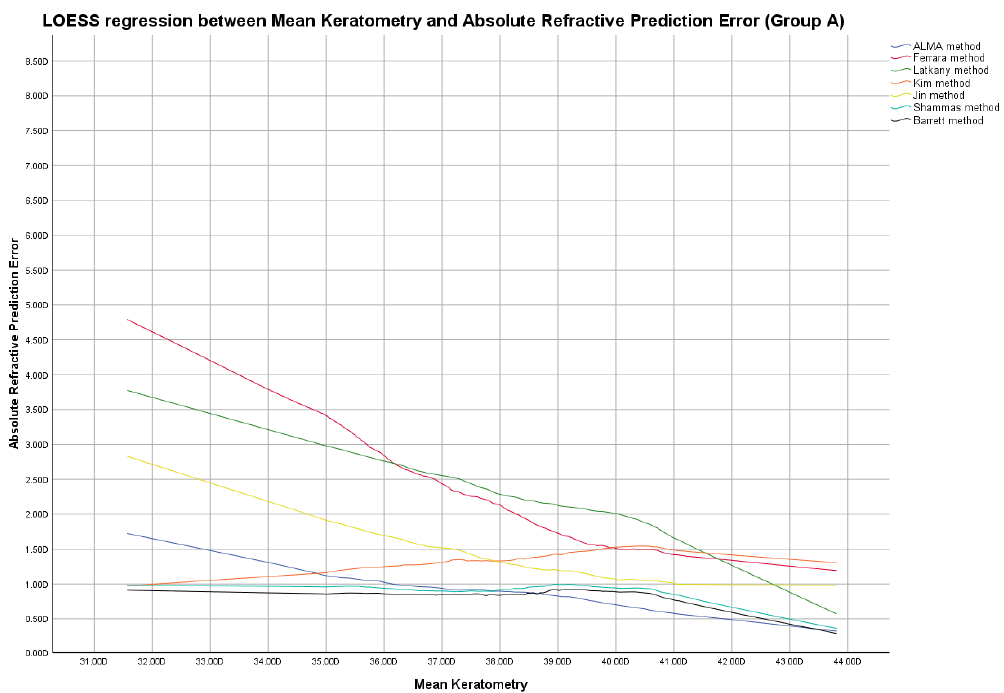
Figure 1. Locally estimated scatterplot smoothing (LOESS) curve between refractive prediction errors generated for each examined formula and the related mean keratometry value. (Group A).